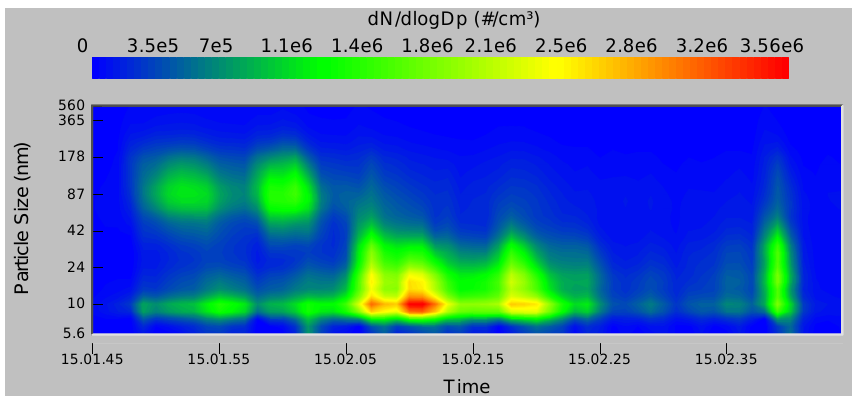
Figure 5. Evolution of the particle number concentration during an entire welding operation along with the highlight showing the particle number size distribution at the maximum particle generation peak.